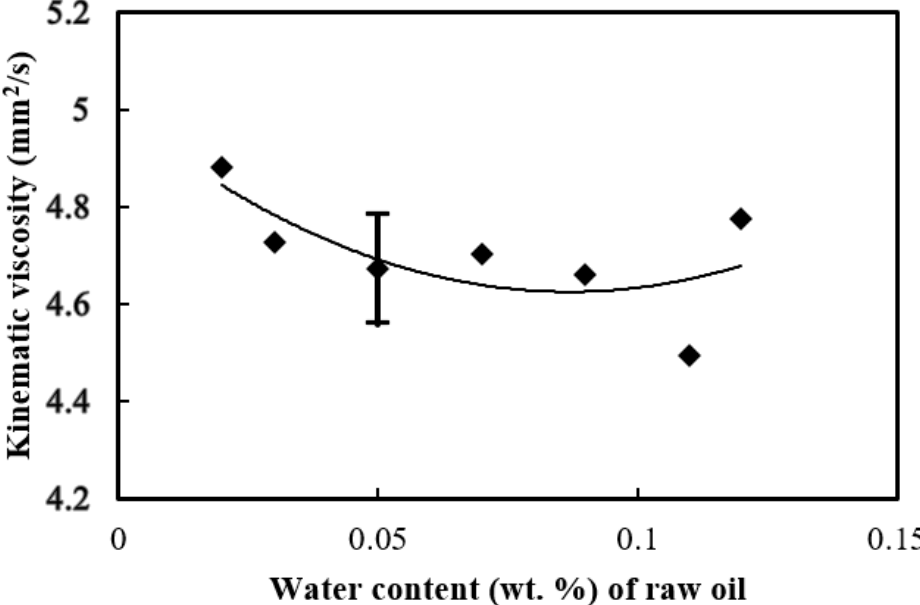
Figure 4. Variations of the kinematic viscosity of the biodiesel product with the initial water content in the raw palm oil.